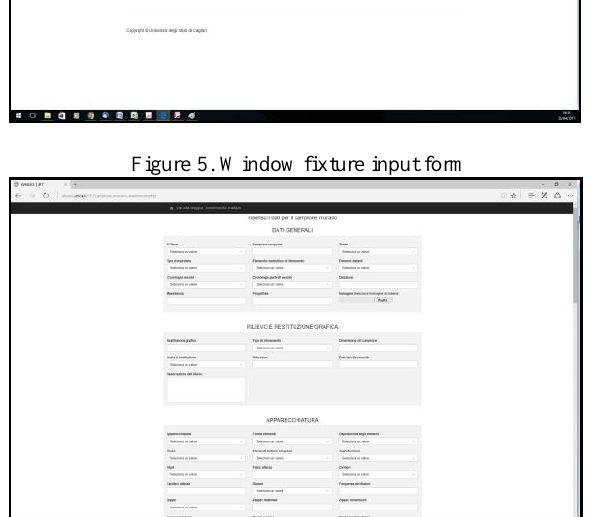
Figure 7. Coordinates input form